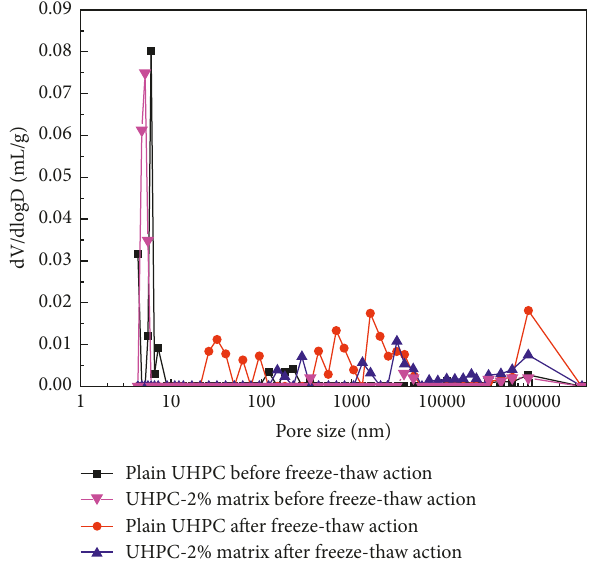
Figure 9: Pore size distribution of plain UHPC and UHPC-2% matrix before and after freezing-thawing